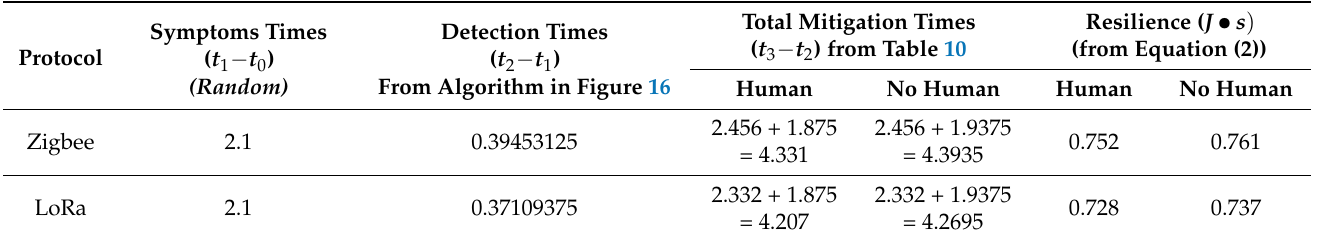
Table 11. Energy resilience calculation from simulation data.